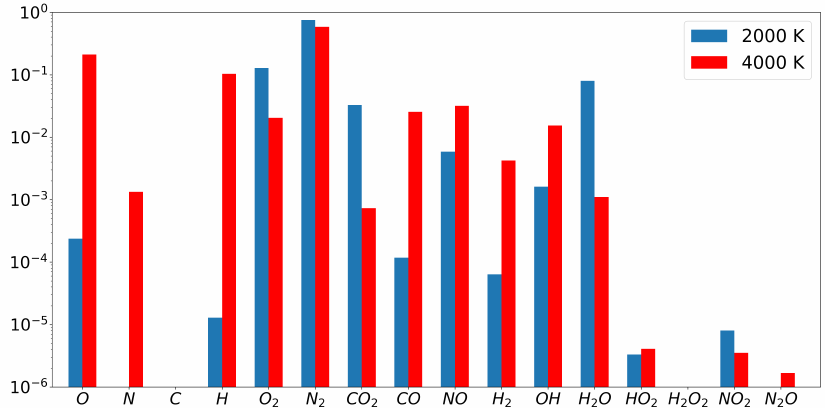
Figure 2. Molar fractions of the components for temperatures of 2000 K and 4000